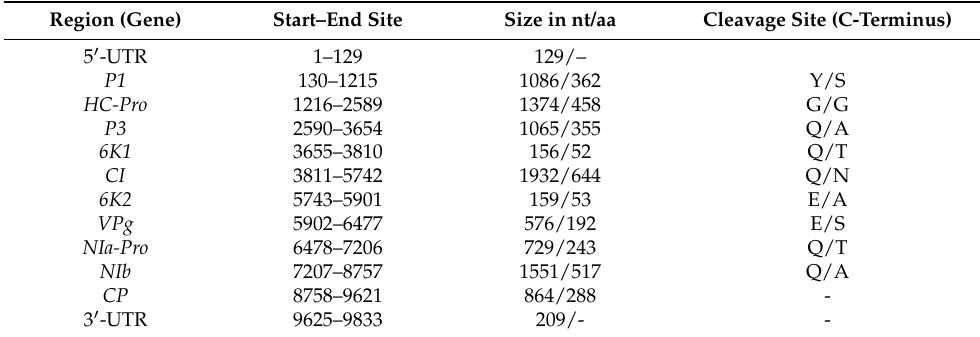
Table 1. Genome structure and nine putative protease cleavage sites in polyproteins of CCLB, LWLB and WFLB14.